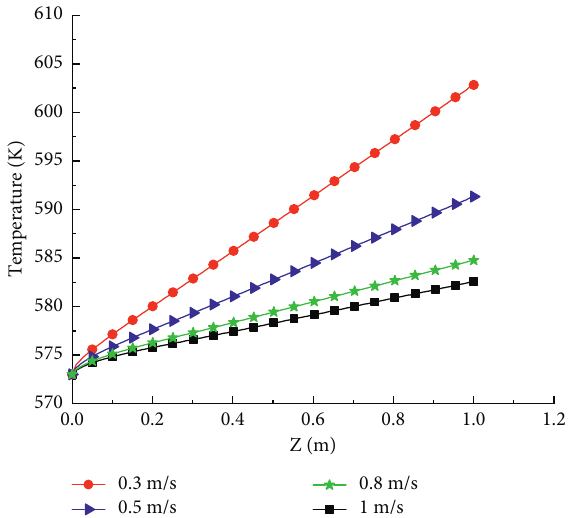
Figure 9: Temperature variation along the axial direction at dif- ferent velocities.